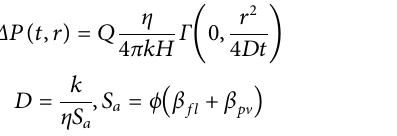
Frontiers in Earth Science |